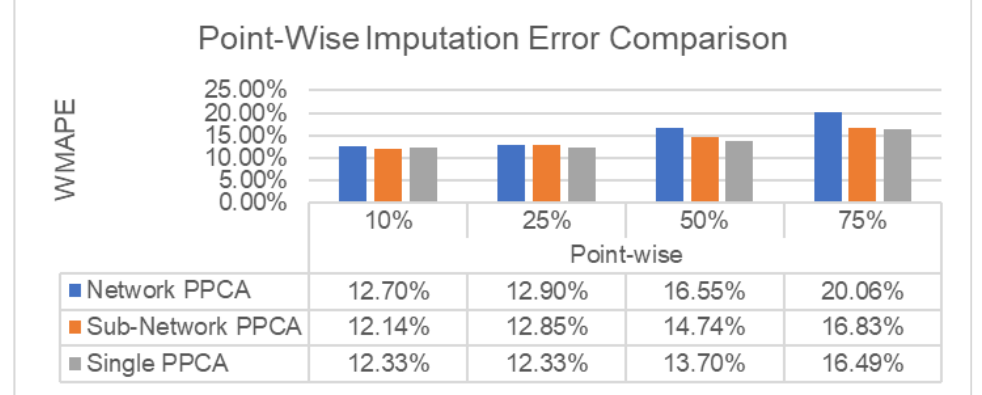
Figure 6. Imputation performance comparison for Network PPCA , Sub-Network PPCA , and Single PPCA for Scenario A with different point-wise missing data ratios.